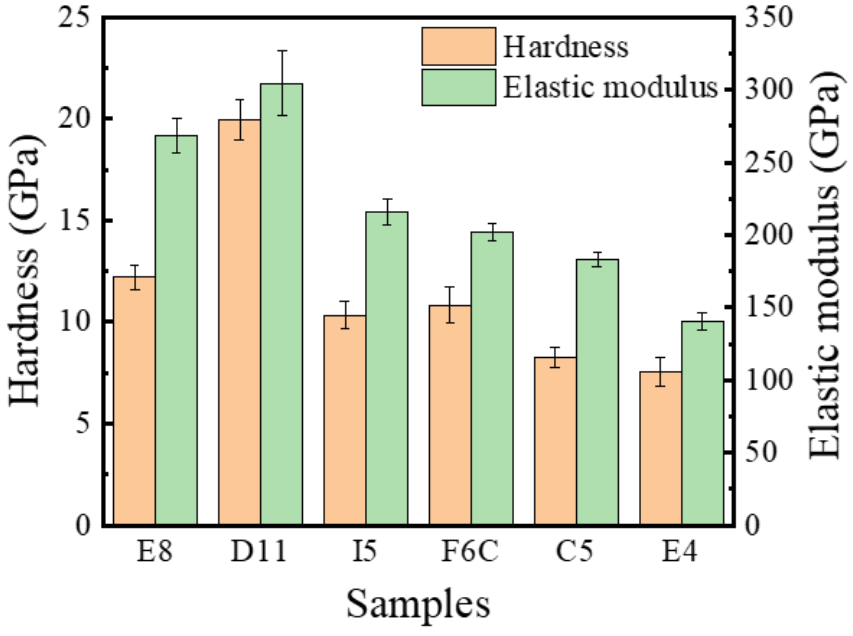
Figure 10. Nano hardness and elastic modulus ZrMoTaW RMPEA thin films: E8, D11, I5, F6C, C5, E4. Table 7. The hardness values of refractory metals, RMPEAs blocks, and RMPEAs thin films.